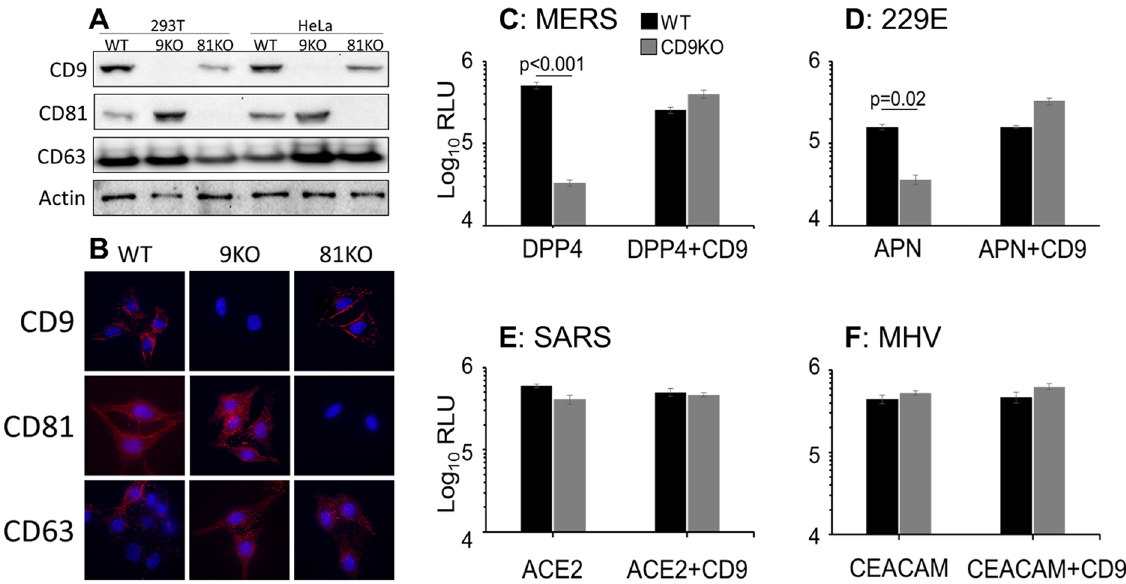
Fig 1. CoV-S mediated entry into tetraspanin KO cells. (A) Western blot analysisof 293T and HeLa clonal cell lines. Actin and the tetraspanin CD63 are used as loadingcontrols. (B) Immunofluorescentanalysisof HeLa clonalcell lines. Unpermeabilizedcells were incubatedwith primary antibodies against CD9, CD81 or CD63 as indicated. 293T WT or CD9KO cells were transfected with the appropriate receptors and CD9 where indicated.These cells were transduced with viruses pseudotyped with S proteinsfrom MERS (C), 229E (D), SARS (E), or MHV (F). Pseudovirus transduction was measuredby luciferase